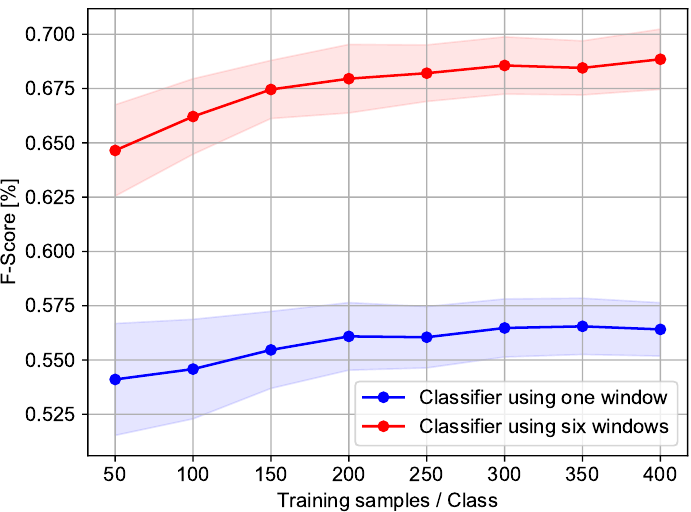
Figure 11. Learning curve for a comparison between SVM using one size of pixel window and SVM using six sizes of pixel windows. Solid lines represent the average of F-score. Colored areas (red and blue) are within the standard deviation